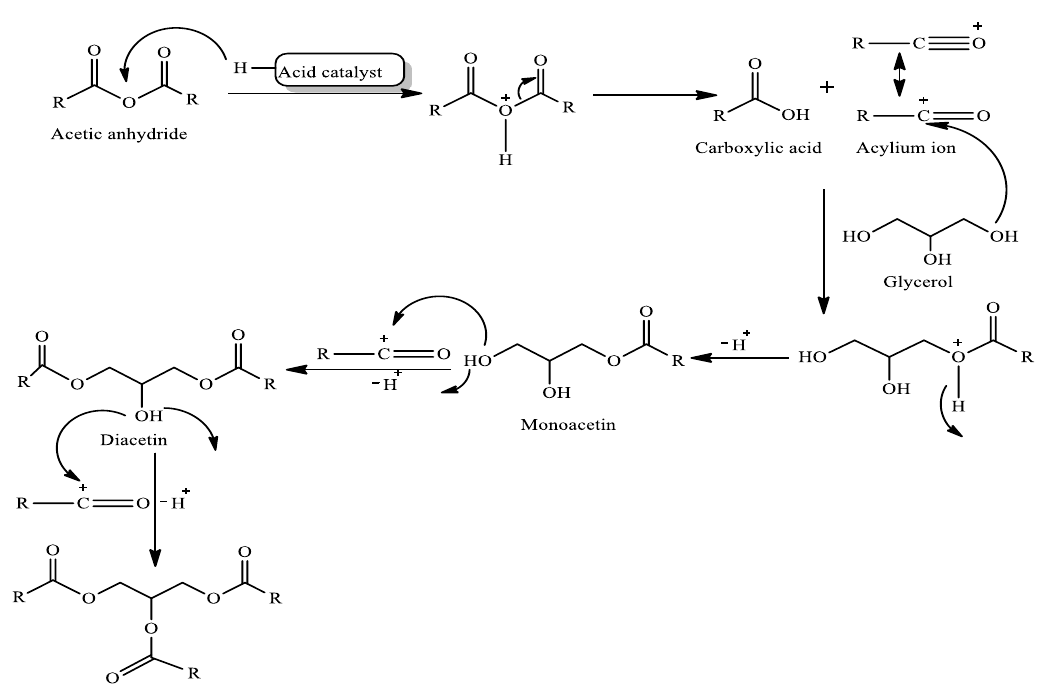
Scheme 7. Plausible reaction mechanism for the acetylation of glycerol with acetic anhydride